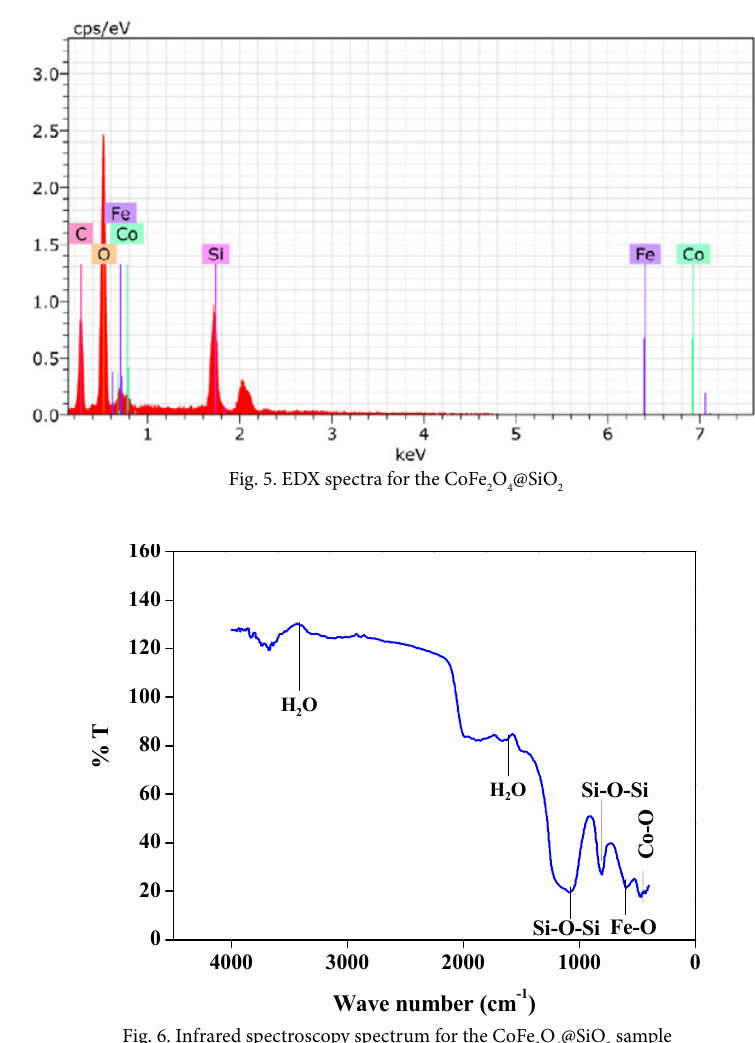
Figure 6: Infrared spectroscopy spectrum for the CoFe 2 O 4 @SiO 2 sample Fig. 6. Infrared spectroscopy spectrum for the CoFe 2 O 4 @SiO 2